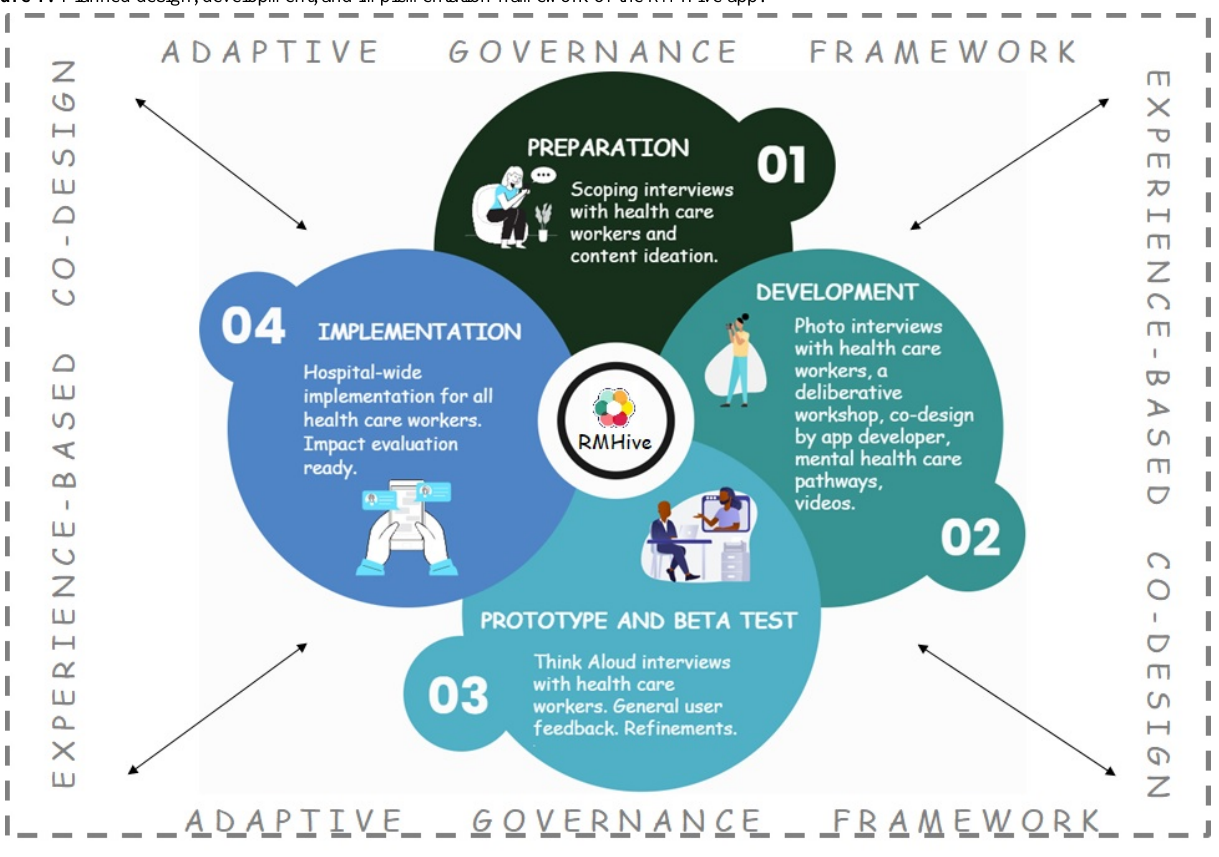
Figure 1. Planned design, development, and implementation framework of the RMHive